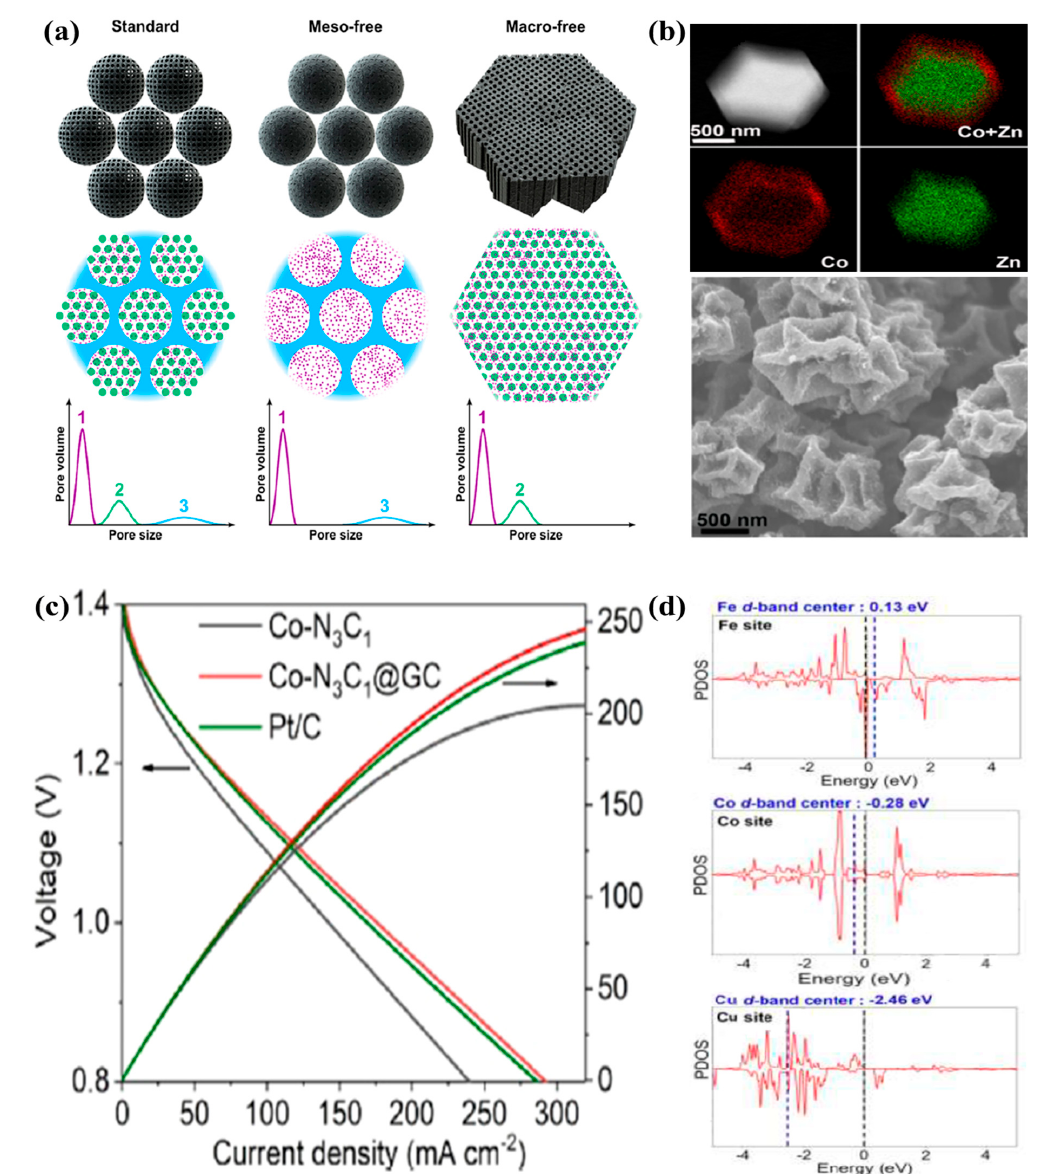
Figure 6. ( a ) The scheme and porous structures of the three model catalysts [82]. ( b ) The STEM-EDS elemental maps and SEM images of Co / Zn-ZIF@ZIF-67 [84]. ( c ) The polarization curve and power density plot of the battery [84]. ( d ) The partial density of states (PDOS) of Fe, Co, and Cu in FeSA@HNCNx, CoSA@HNCNx, and CuSA@HNCNx, respectively [85].